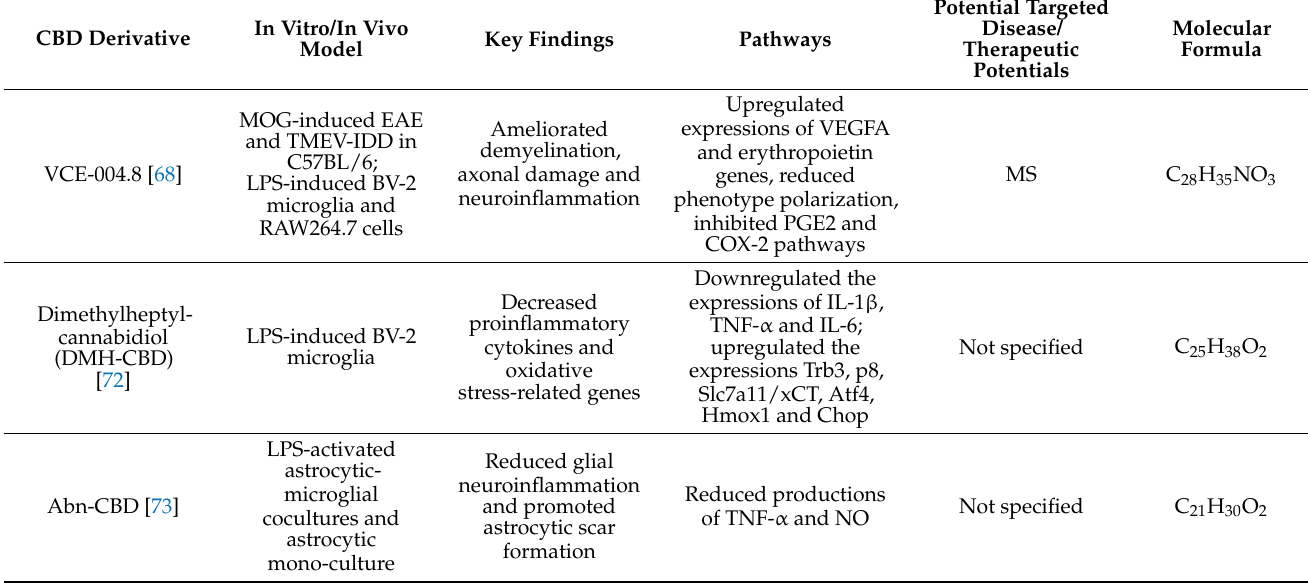
Table 2. A summary of preclinical studies on the anti-neuroinflammatory activity of synthetic CBD derivatives in relation to microglial activation and neuroinflammatory